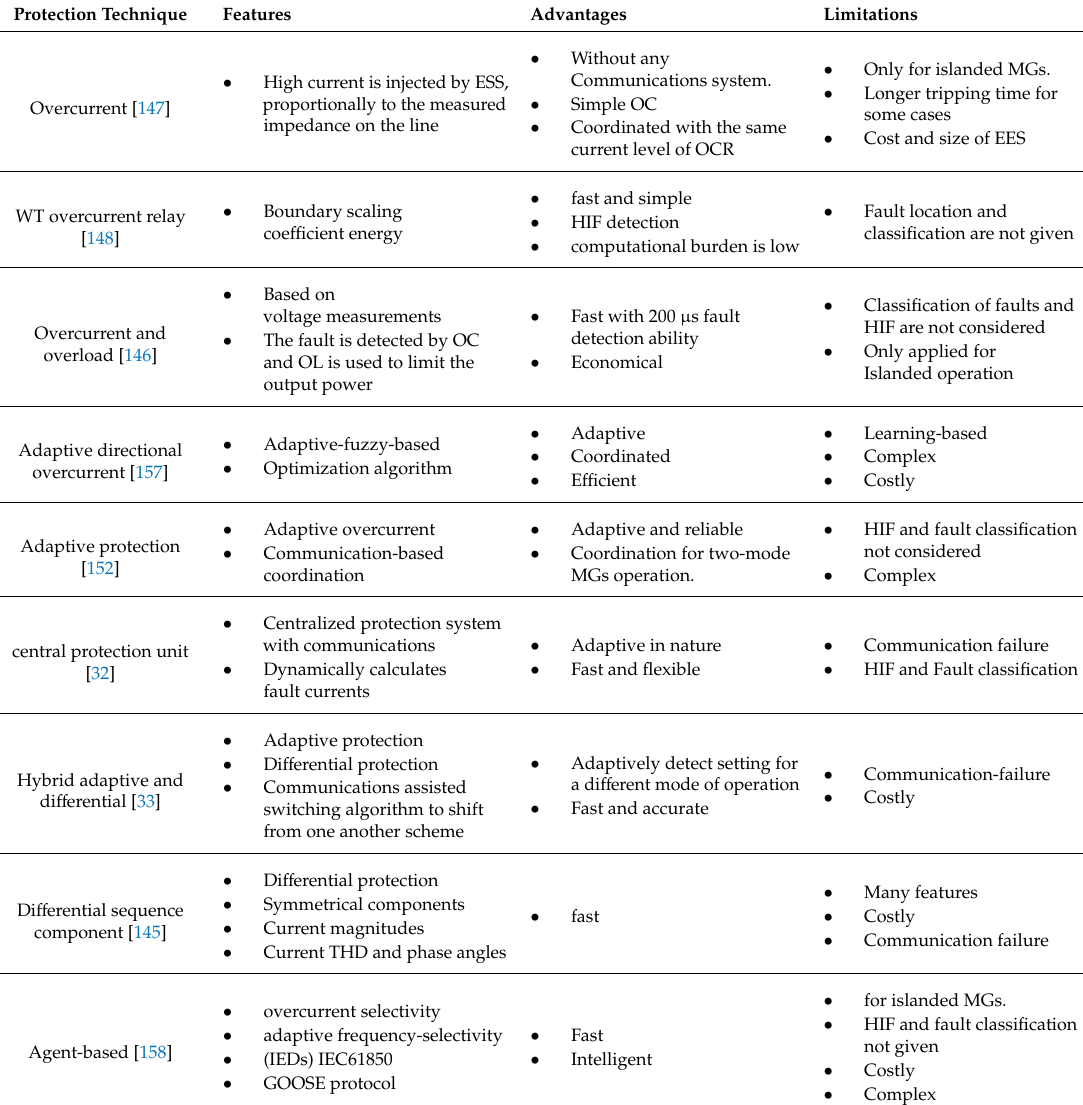
Table 4. Protection schemes for